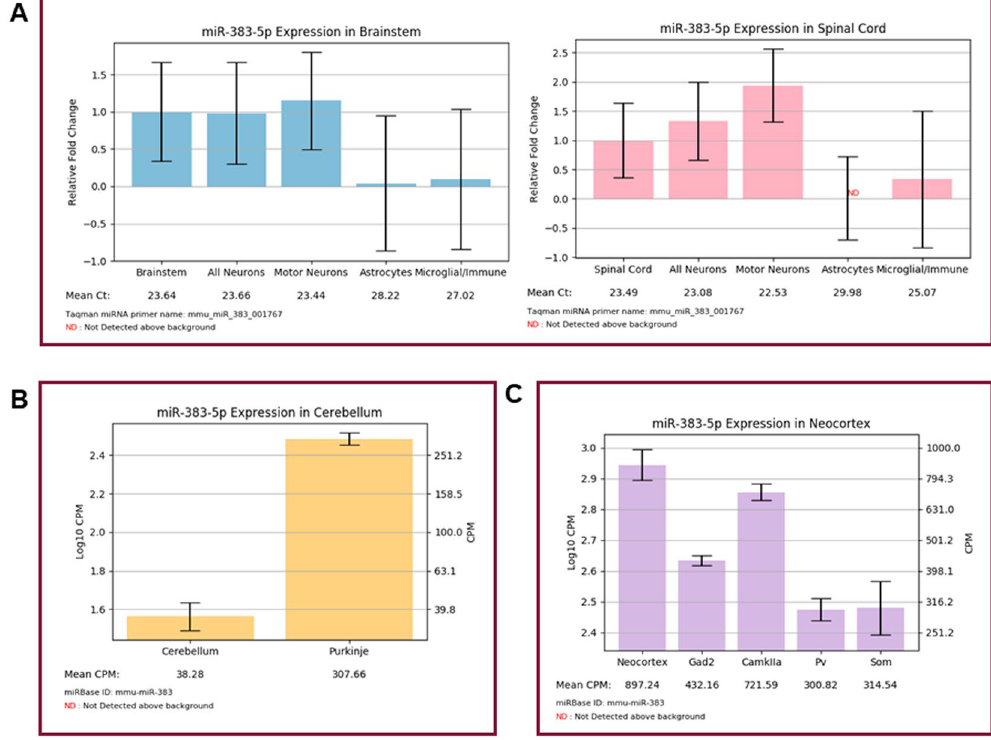
Figure 3. ( A ) ‘Search by miRNA’ output for miR-383-5p in the spine and brainstem. Expression is consistently and statistically enriched in neuronal cells over glia (n = 3–4 mice; mean ± SEM). (B) ‘Search by miRNA’ output for miR-383-5p in the cerebellum. Expression is enriched in Purkinje neurons, relative to the cerebellum as a whole (n = 2–3 mice; mean ± SEM). (C) ‘Search by miRNA’ output for miR-383-5p in the neocortex. Expression is highly expressed across neuronal subtypes but is most highly expressed by CamKIIa-positive glutamatergic neurons (n = 2–3 mice; mean ± SEM). Only the more predominant and conserved 5p strand is displayed. The “Claret” colored frame indicates that miR-383-5p is broadly conserved among most